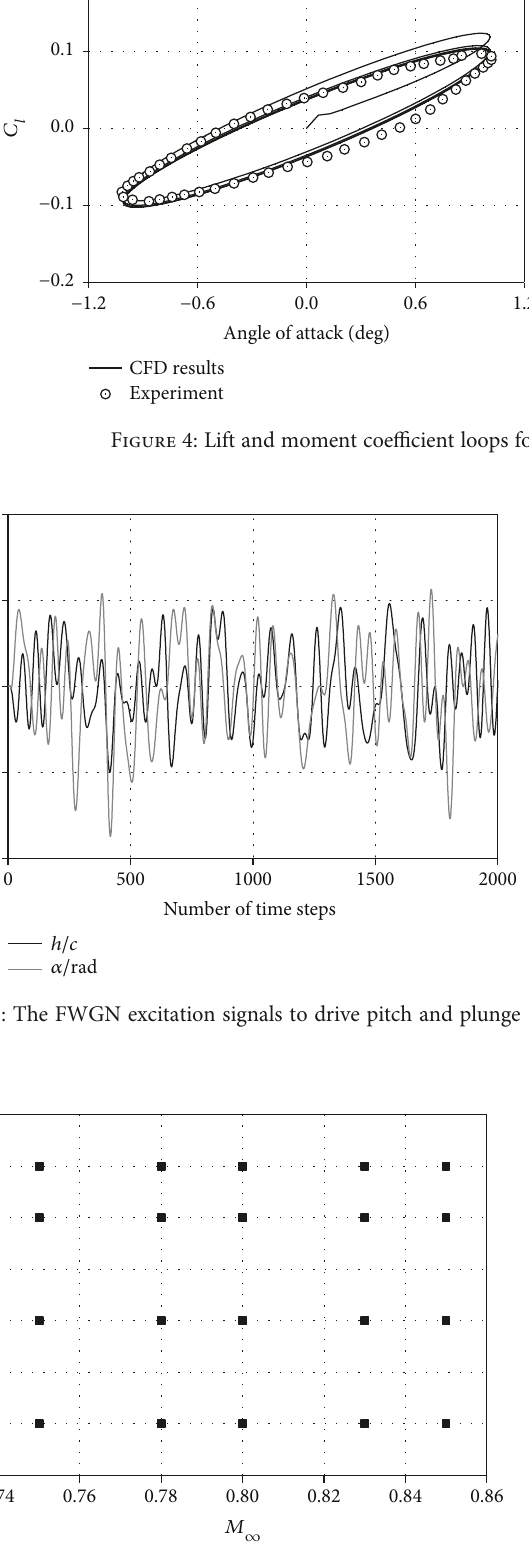
Figure 6: The fl ight parameter samples to cover the range of concern.